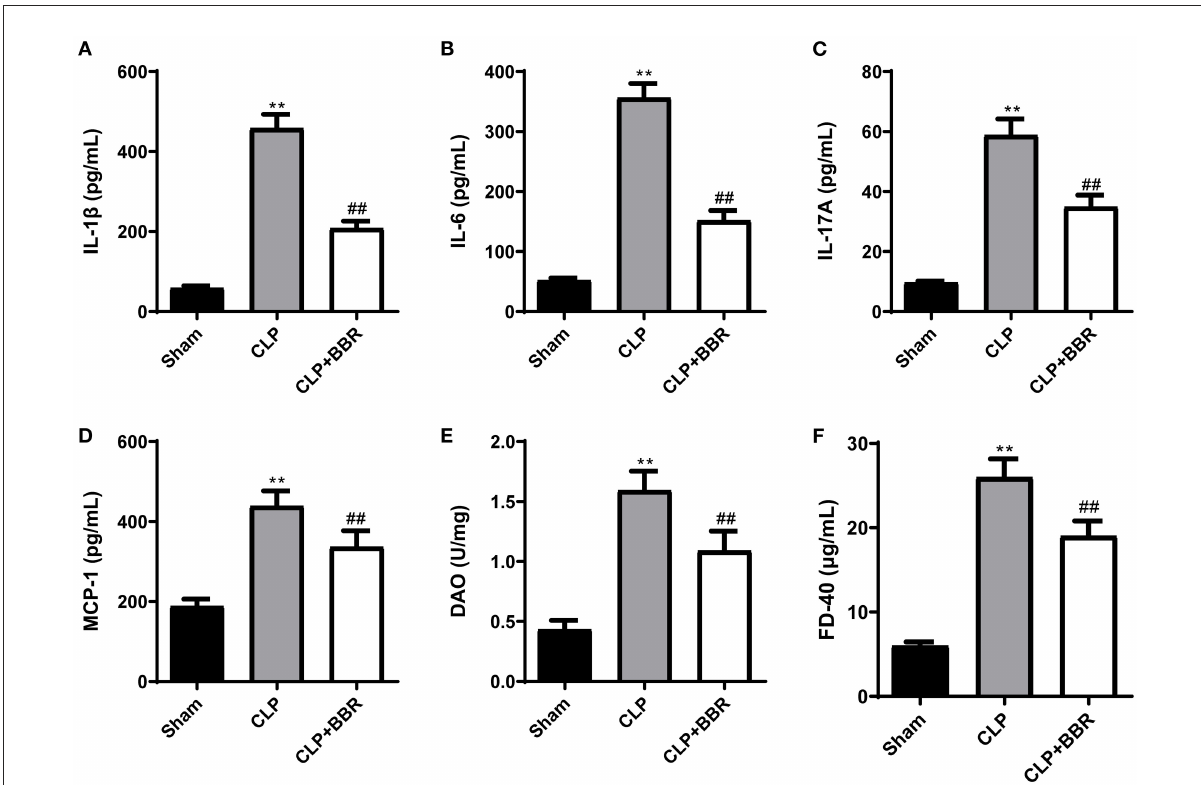
FIGURE2 Berberine improved the inflammation and the gun barrier function in cecal ligature and puncture rats. The (A) interleukin (IL)-1 β , (B) IL-6, (C) IL-17A, and (D) monocyte chemoattractant protein-1 (MCP-1) levels in the serum of CLP rats were decreased by berberine treatment. The (E) diamine oxidase (DAO) and (F) fluorescein isothiocyanate-Dextran 40 (FD-40) levels in the plasma of CLP rats were used to measure the gut barrier function and berberine treatment decreased them ( n = 6). Data are shown as mean ± standard deviation. ** p < 0.01 vs. sham group; ## p < 0.01 vs. CLP group. CLP, cecal ligature and puncture; BBR,